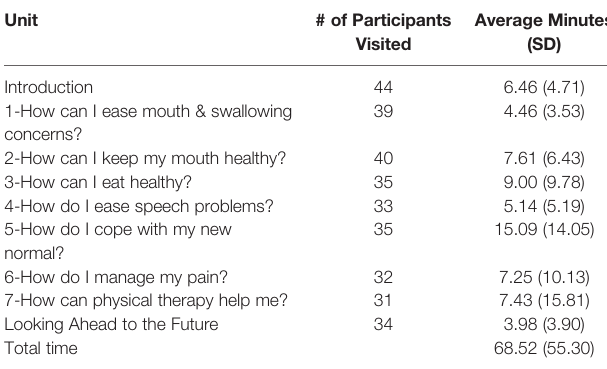
TABLE 2 | Program Usage (n = 44).